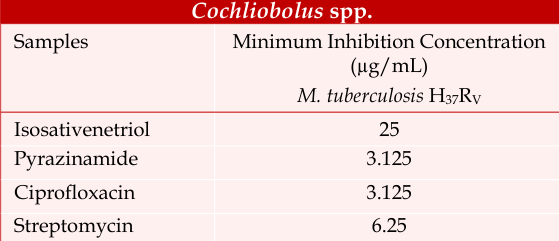
Antimycobacterial activity of isosativenetriol from Cochliobolus sp p . Samples